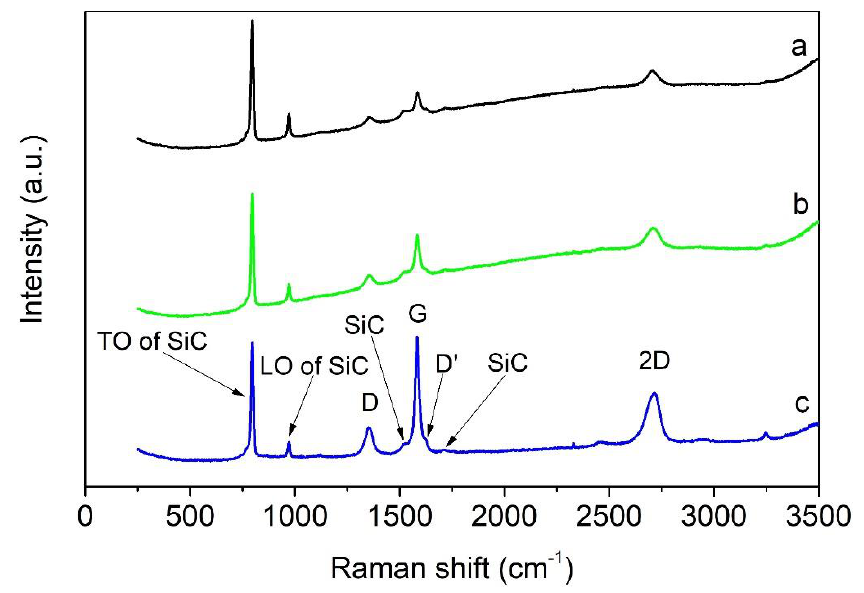
Figure 3. Raman spectra of individual layers in 3-layered composites: ( a ) SiC layer, ( b ) S5GNP layer, ( c ) S15GNP layer. ( c ) S15GNP